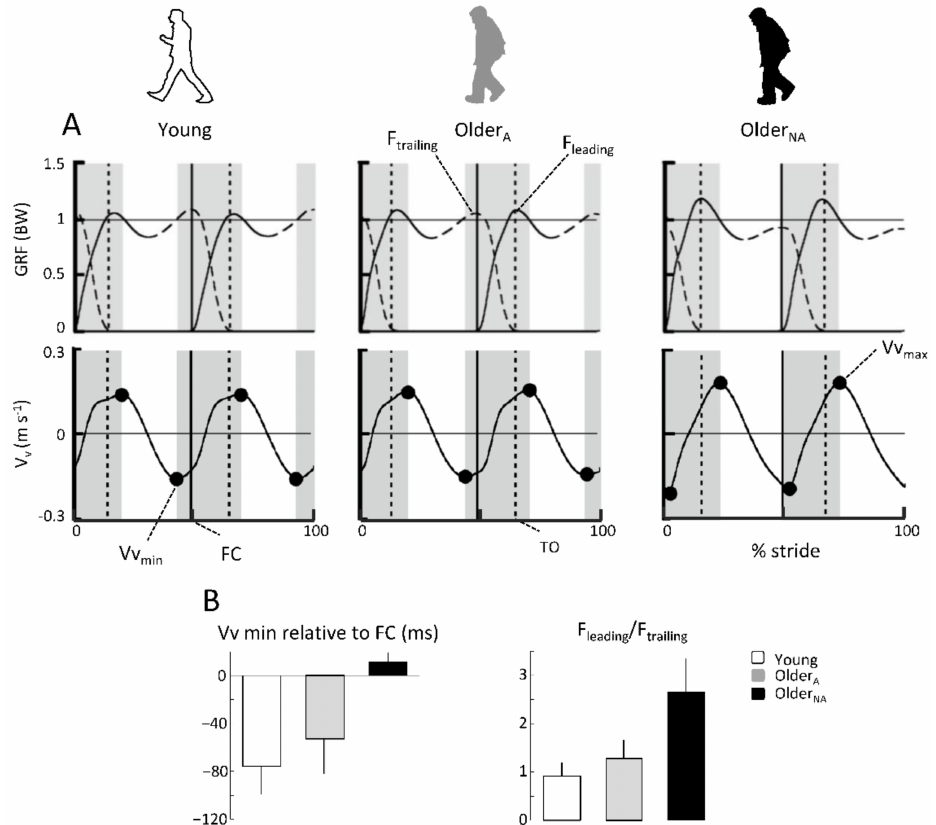
Figure 1. Definition of the step-to-step transition modes. ( A ) Mean curves of the vertical component of the ground reaction force (GRF, expressed in body weight) acting upon each leg separately (continuous line: leading leg; dotted line: trailing leg) for young and older groups with an anticipated (Older A ) and non-anticipated step-to-step transition (Older NA ). ( B ) Left: time of occurrence distribution of Vv min relative to foot contact (FC). Negative values indicate anticipated transition. Right: ratio between the mean value of impact force on the leading leg (F leading ) and on the trailing leg (F trailing ) during the step-to-step transition. Bars correspond to mean value and the line to 1 standard deviation. White: young adults; grey: older adults with anticipated step-to-step transition; black: older adults with non- anticipated step-to-step transition (all plots are redrawn with permission from Meurisse et al.